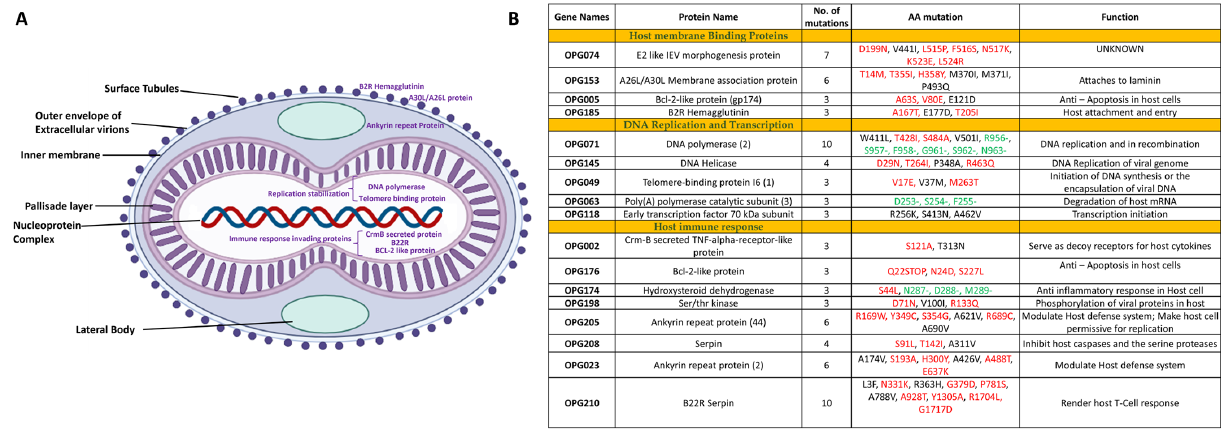
Figure 3. ( A ) Structures depicting the mutations in the Indian MPXV strains in comparison to the MPXV reference sequence. ( B ) List of the nonsynonymous mutations in the Indian MPXV sequences. The red denotes the mutations that are substitution mutations, and the green denotes the mutations that are deletion mutations.